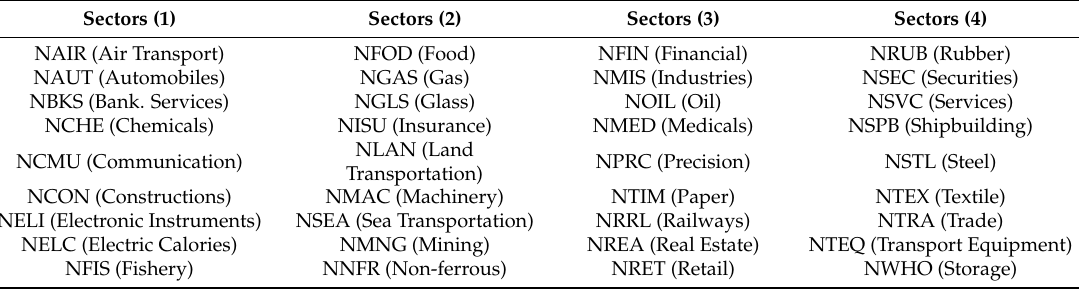
Table 2. Thirty-six sectors of the Japanese